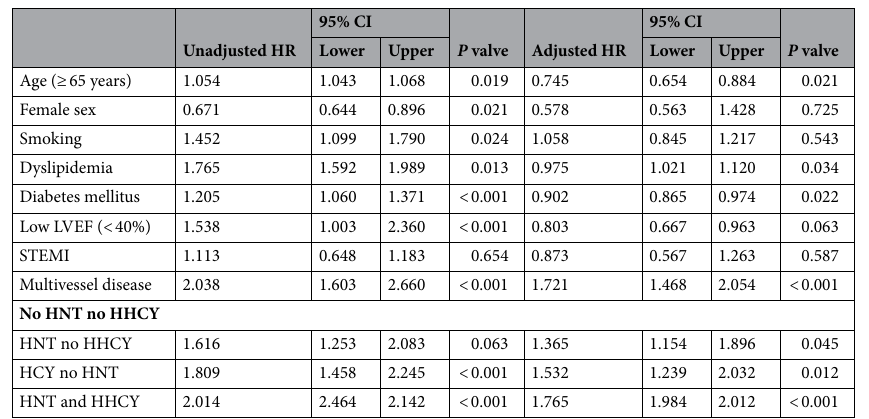
Table 4. Univariate and multivariate analysis for independent predictors of 1-year MACEs. MACE, major adverse cardiac events; HR, hazard ratio; CI, confidence interval; LVEF, left ventricular ejection fraction; PCI, percutaneous coronary intervention; STEMI, ST-segment elevation myocardial infarction; HNT, hypertension; HHCY, high